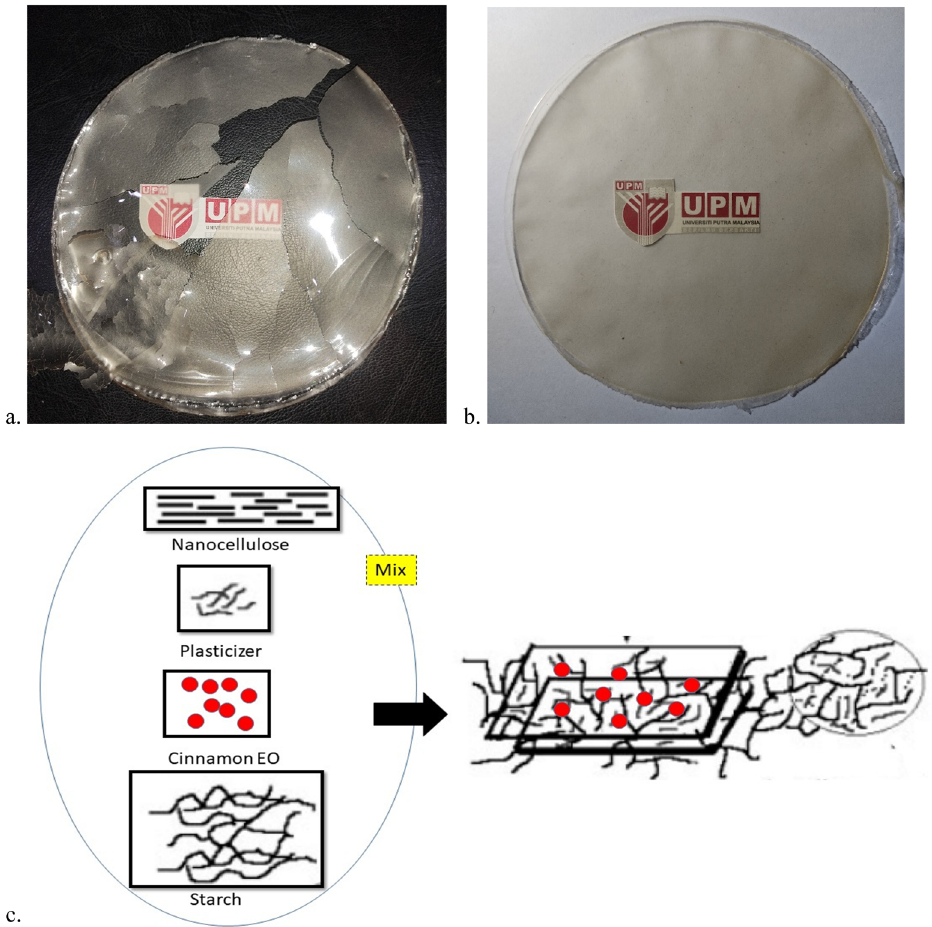
Figure 4: ( a ) SPS fi lm without a plasticizer and ( b ) sugar palm bionanocomposites with a plasticizer. ( c ) Mechanism of reinforcement and the role of plasticizers.